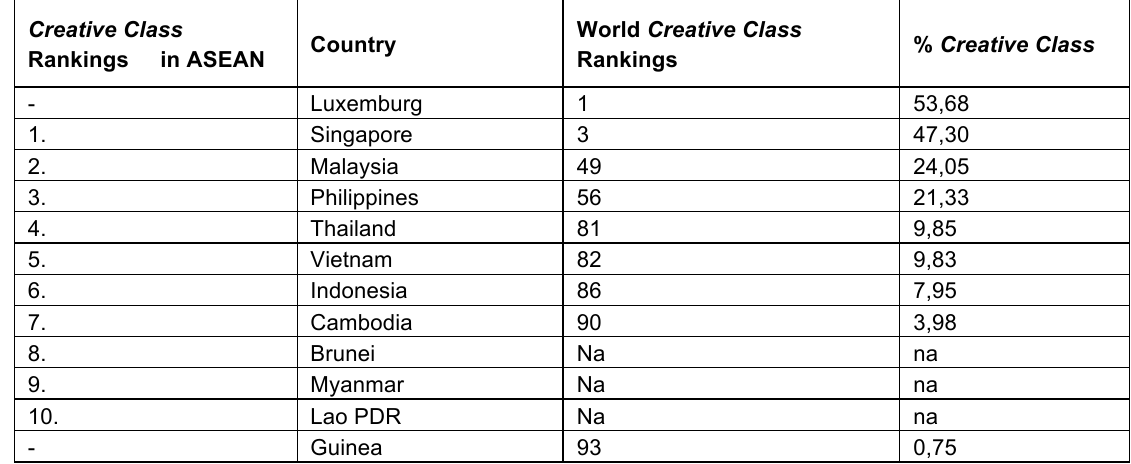
Table 7: The number of Creative Class (% national